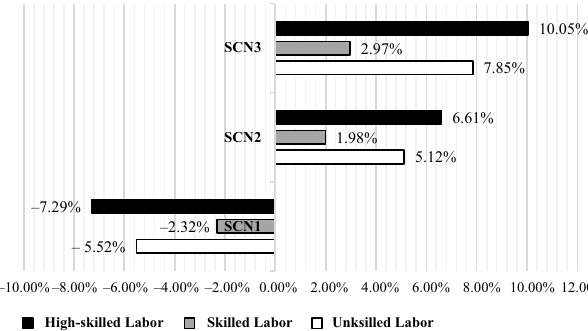
Figure 6. Differences in labor demand from the BAU in 2030 (%)